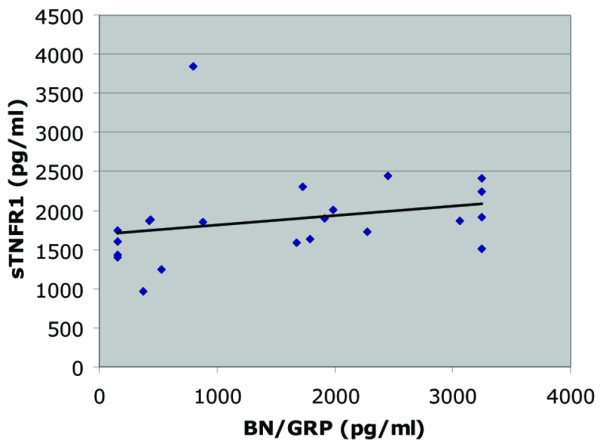
Scatter plot, with linear regression line, showing correlation between BN/GRP and sTNFR1 in serum. Spearman's rank correlation coefficient (rs = 0.61; P < 0.05), measured, using ELISA, in serum from patients with long-standing RA. BN/GRP, bombesin/gastrin-releasing peptide; RA, rheumatoid arthritis; sTNFR1, soluble TNF receptor 1.